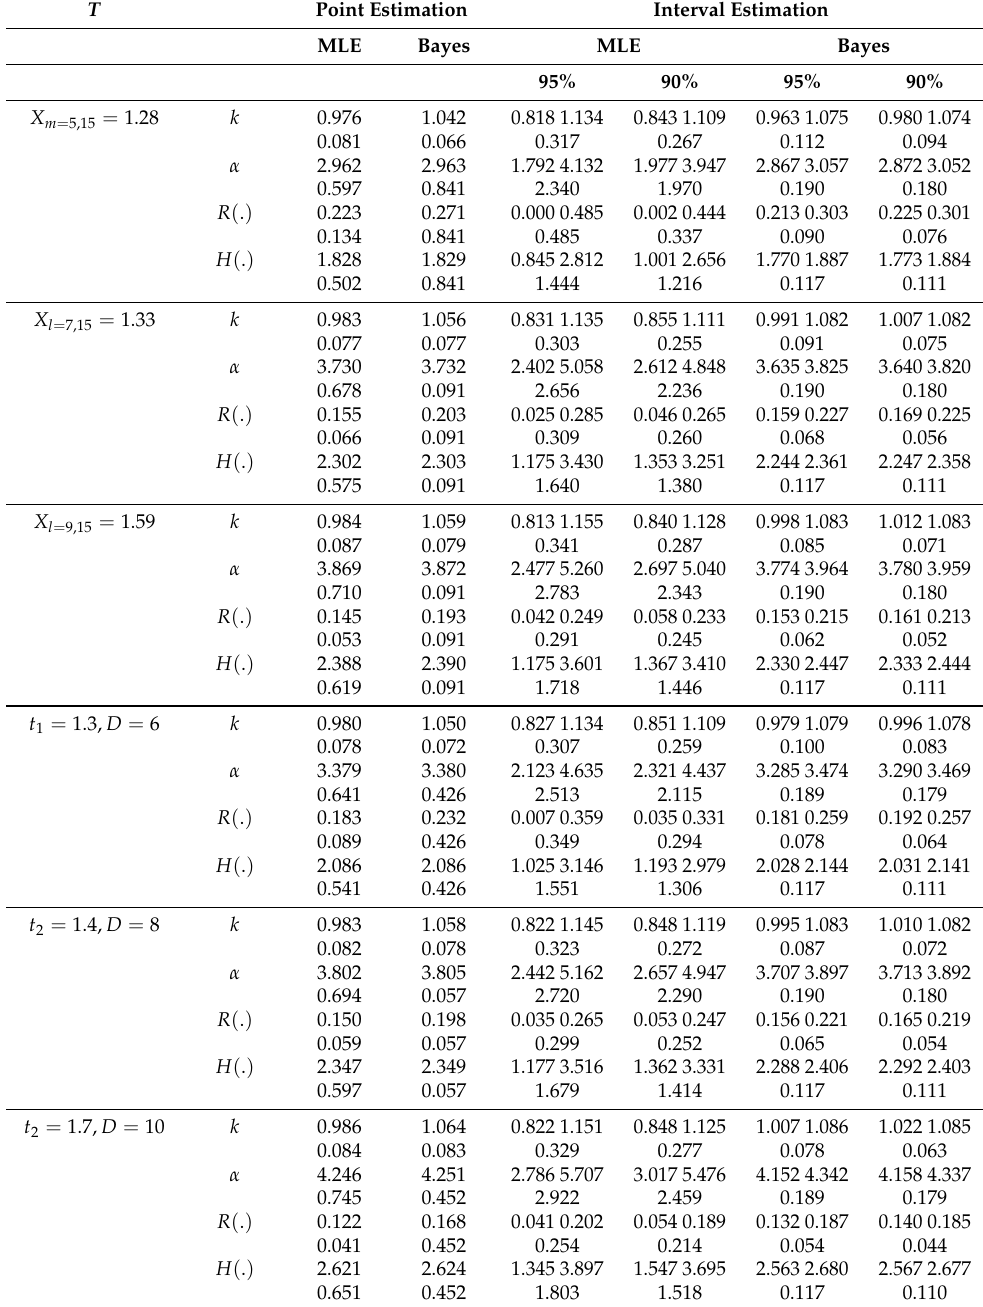
Table 1. Estimation of the unknown parameters, reliability and hazard functions under different censoring